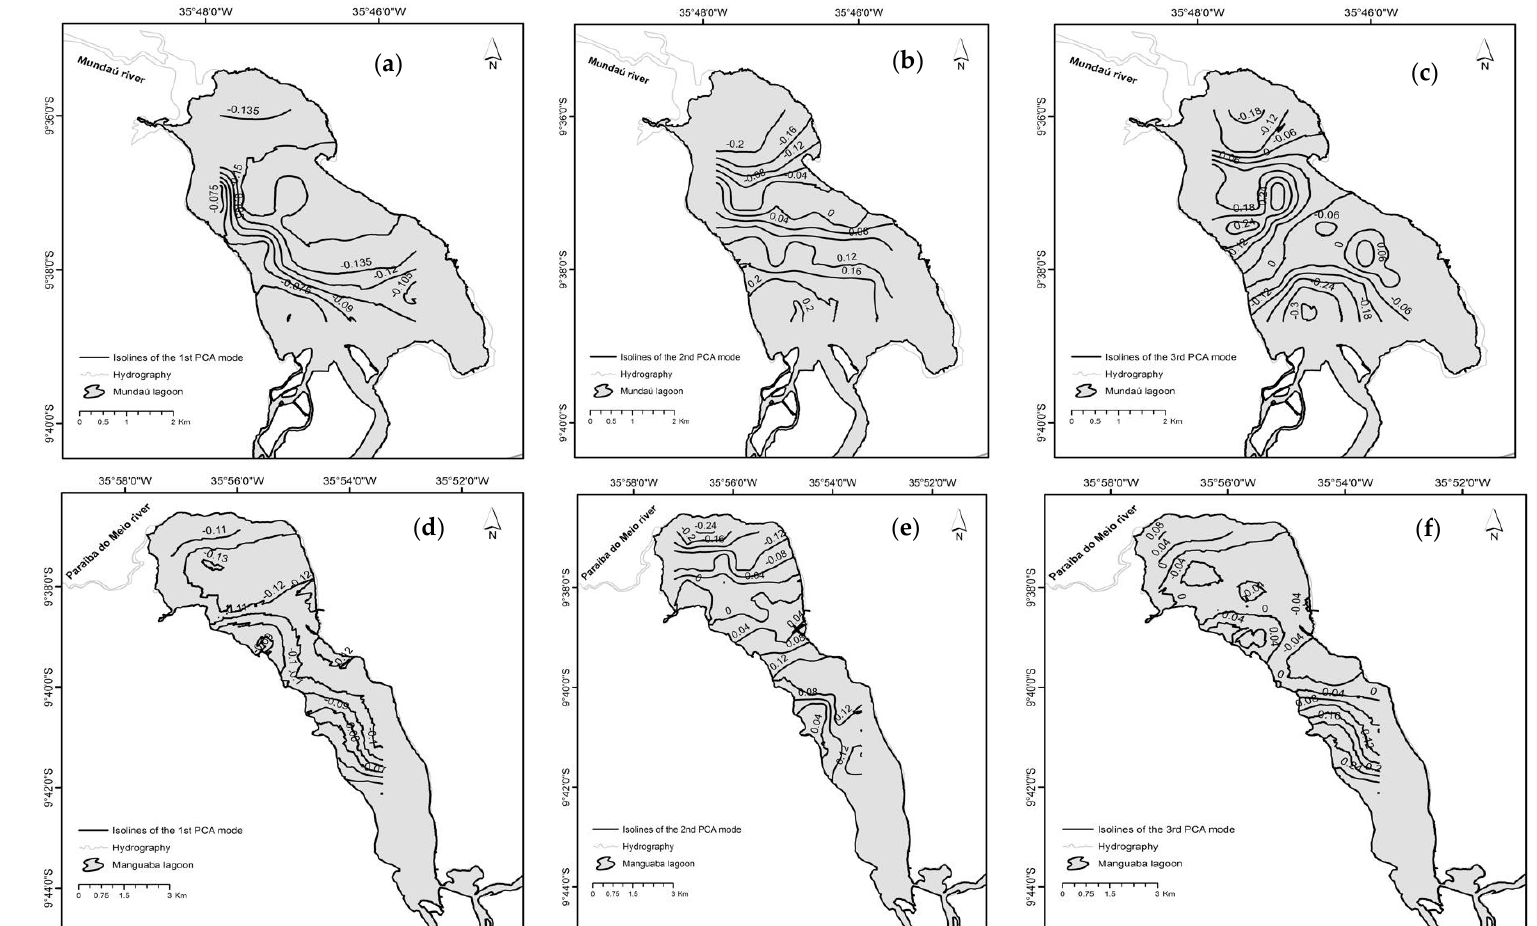
Figure 3. Isolines of the eigenvector values of the co-variance matrix of the ( a , d ) first; ( b , e ) second and ( c , f ) third rotated principal component for Mundaú and Manguaba lagoons.